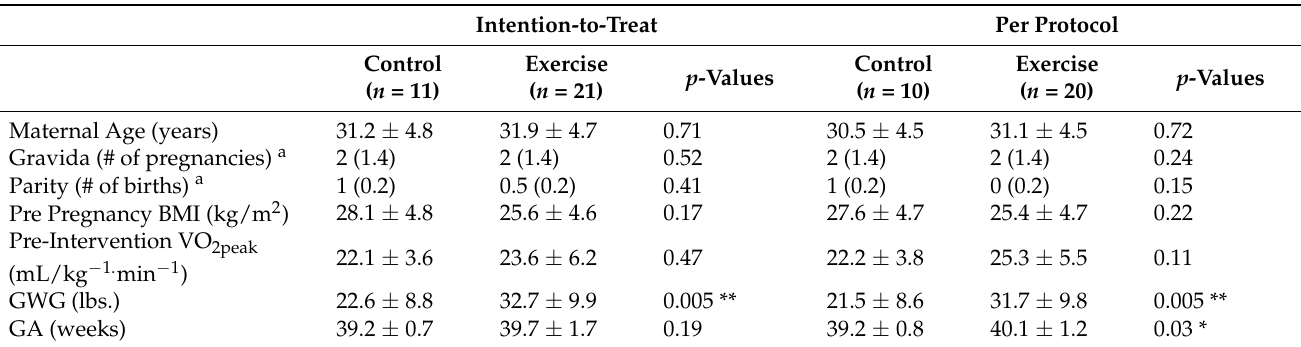
Table 1. Intention-to-treat and per protocol analysis of maternal demographics between aerobic exercise and non-exercising